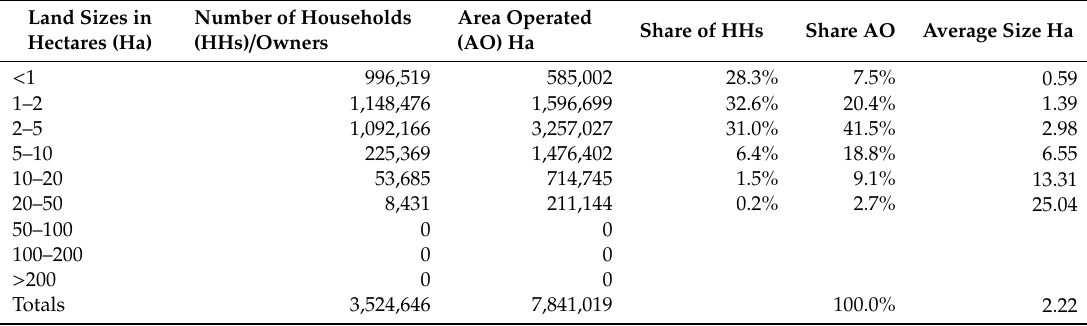
Table 1. Farm land distribution in Tanzania 1993. (Lowder, Bertini, Karfakis and Croppenstedt [103] calculated using LSMS household survey data from the World Bank, plus authors calculation of average farm sizes.).